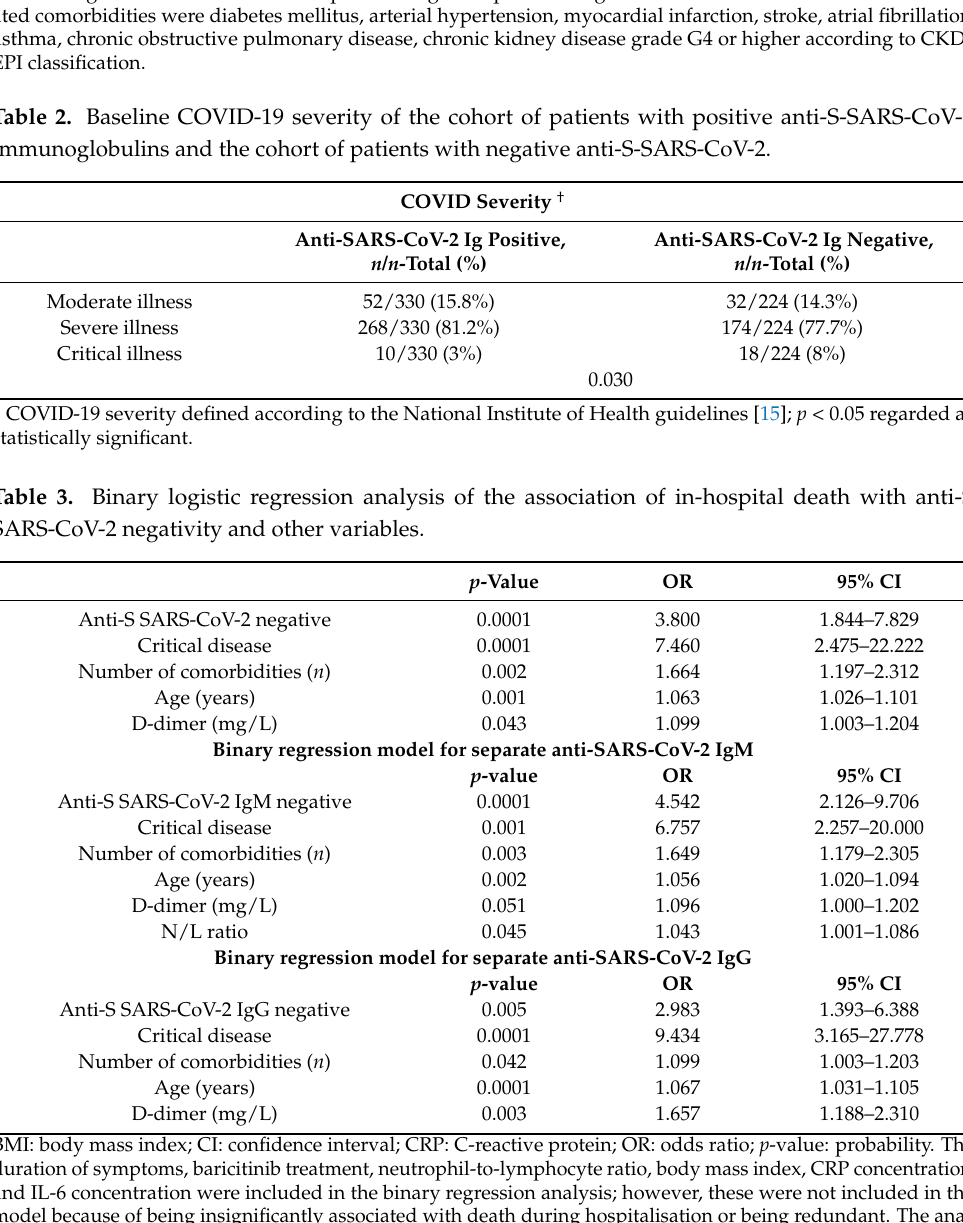
Anti-SARS-CoV-2 Ig Positive n = 330